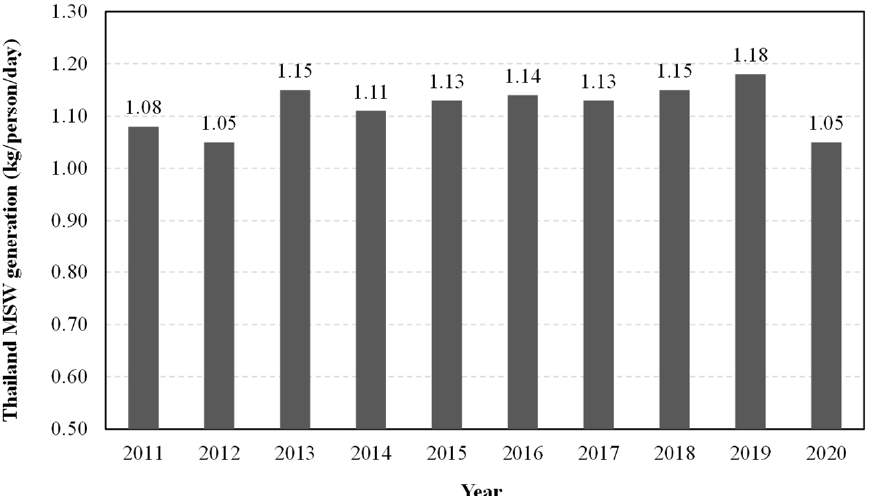
Figure 2. The generation rate per person of waste in Thailand [7,18,19].